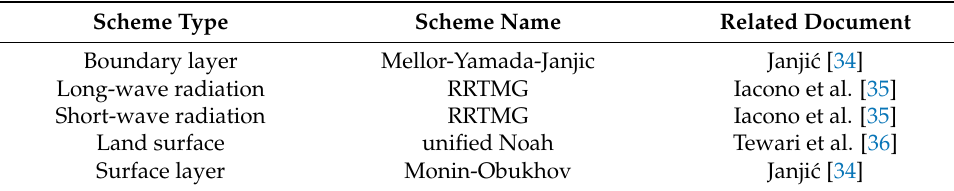
Table 1. Basic parameterization scheme options for experimental